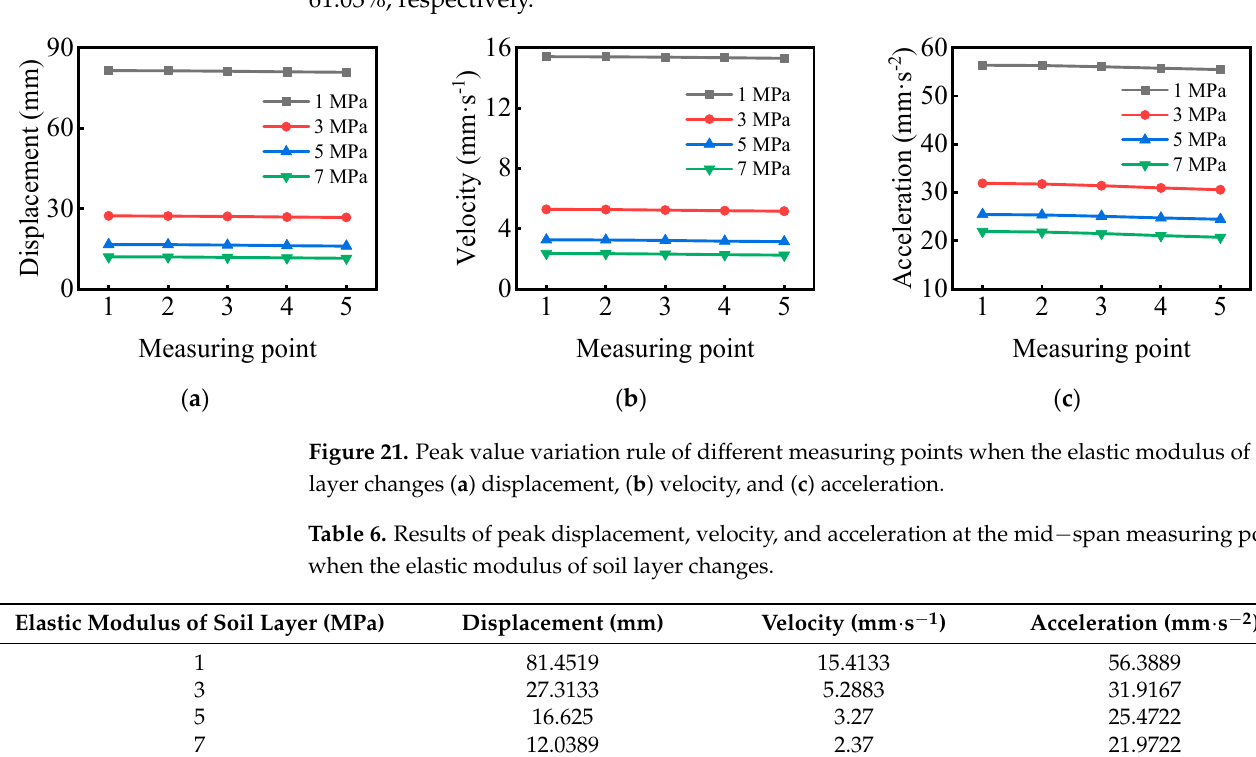
Figure 21. Peak value variation rule of different measuring points when the elastic modulus of soil layer changes ( a ) displacement, ( b ) velocity, and ( c ) acceleration.